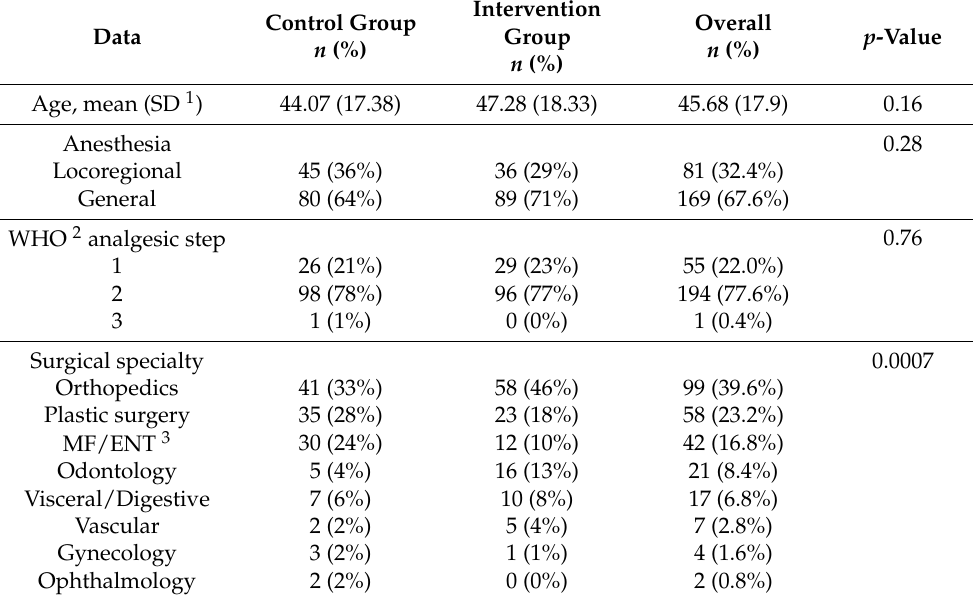
Table 1. Baseline characteristics of the outpatients compared between the control and intervention